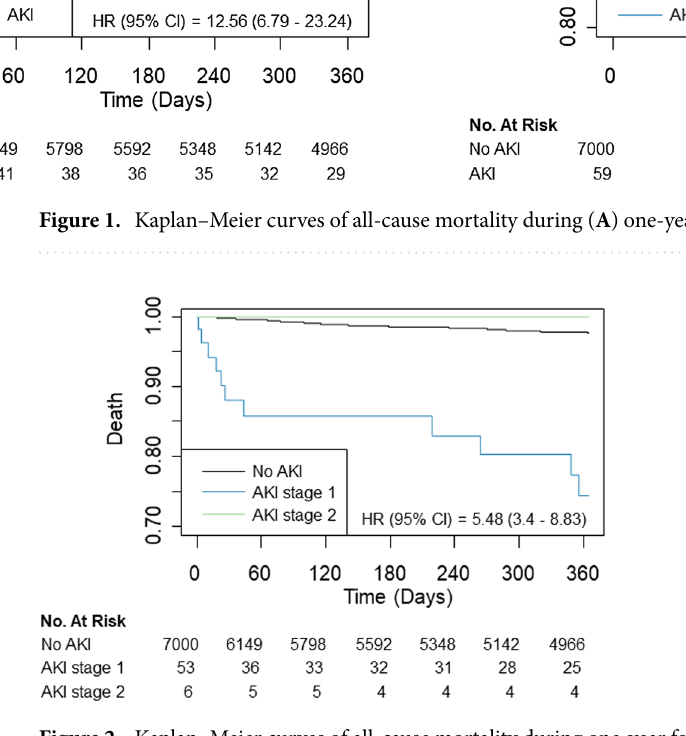
Figure 2. Kaplan–Meier curves of all-cause mortality during one-year follow-up according to stages of AKI.